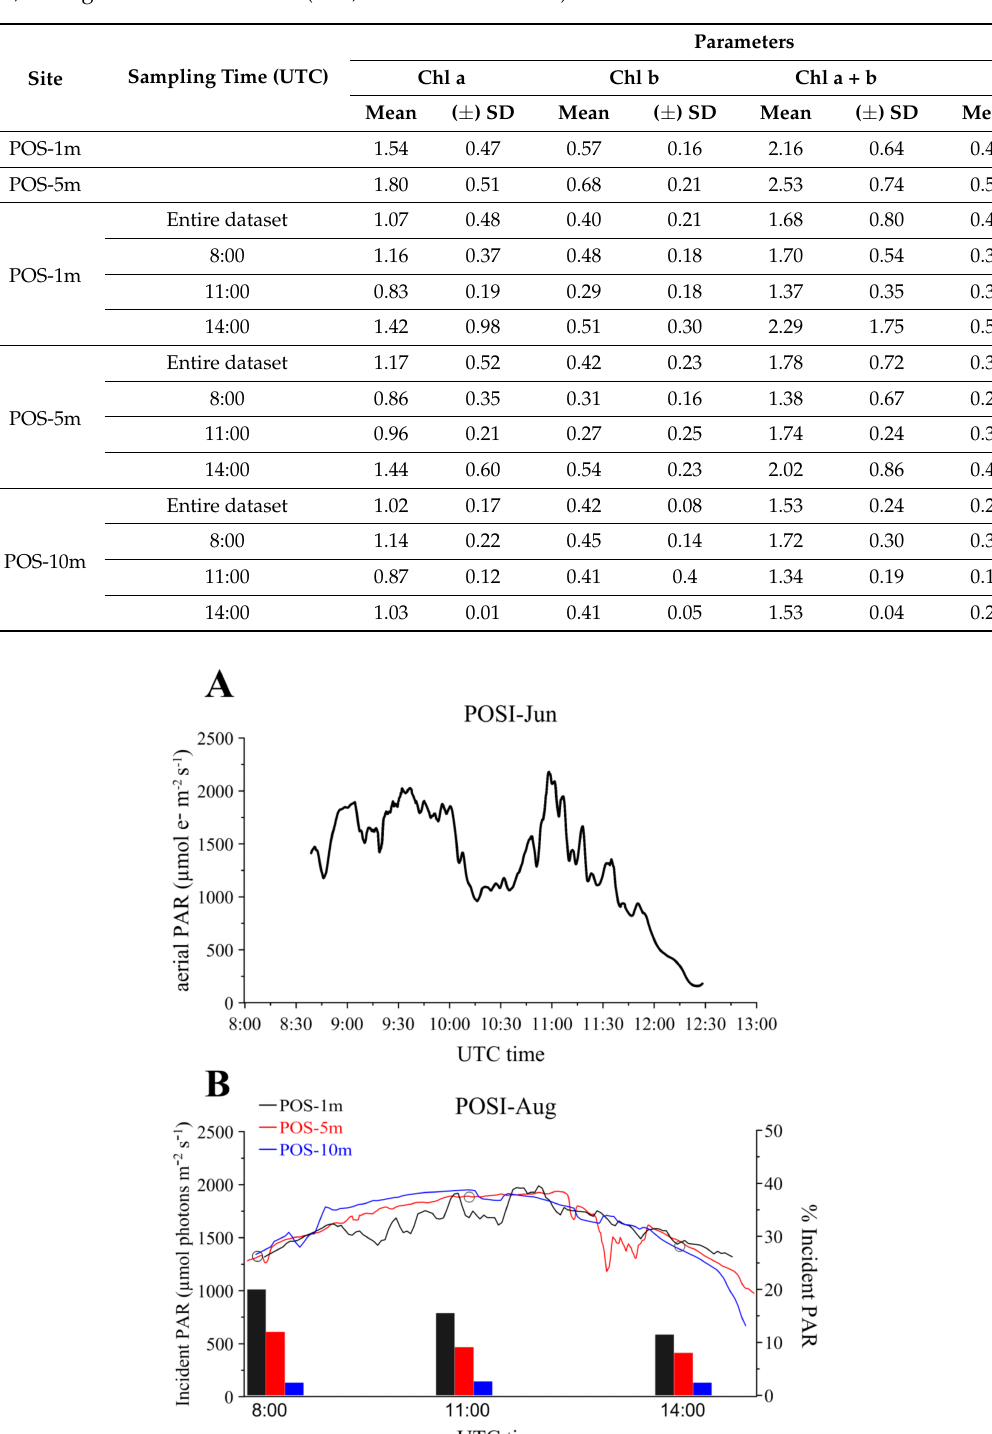
Table 3. Concentration of chlorophyll a (Chl a), chlorophyll b (Chl b), chlorophyll a+b (Chla+b) and total carotenoids (Cx+c) ( µ g cm − 2 ) of P. oceanica , sampled during the campaigns POSI-Jun and POSI-Aug at three sites, POS-1m, POS-5m, andPOS-10m, during three different times (8:00,11:00 and 14:00 UTC).